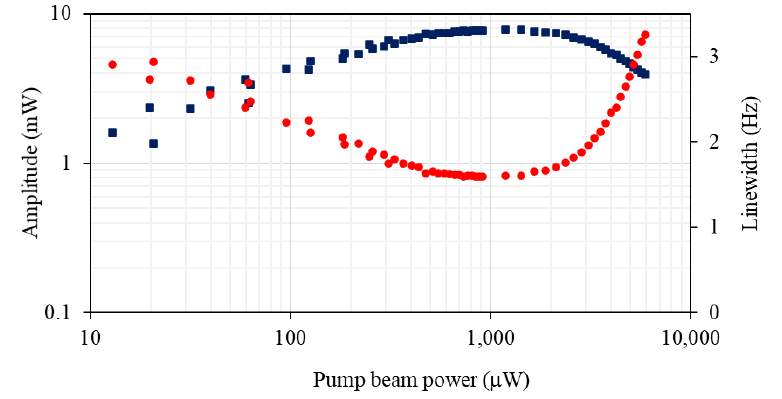
Figure 8. Amplitude (blue squares) and linewidth (red dots) of the rf spectral profile as a function of pump beam power for the degenerate